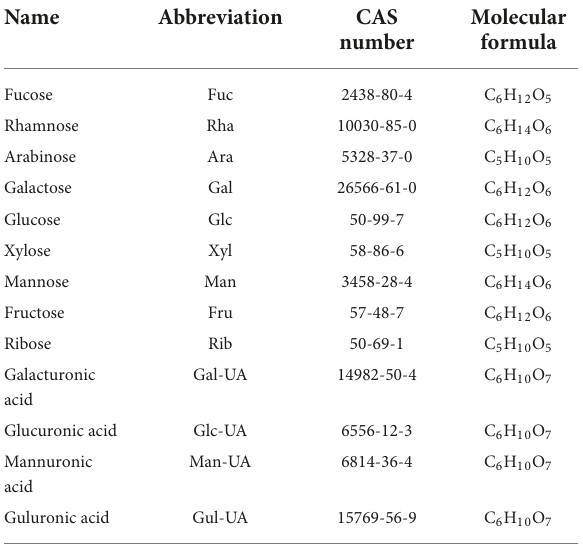
TABLE 2 Information on monosaccharide standards. TABLE 3 The yield and molecular weight of lily